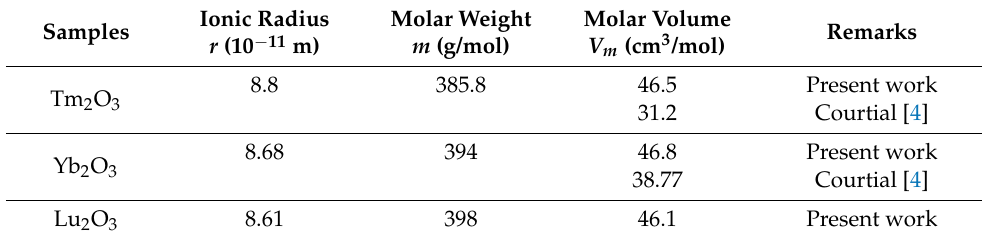
Table 4. Calculated molar volumes of Tm 2 O 3 , Yb 2 O 3 , and Lu 2 O 3 at the melting temperature.